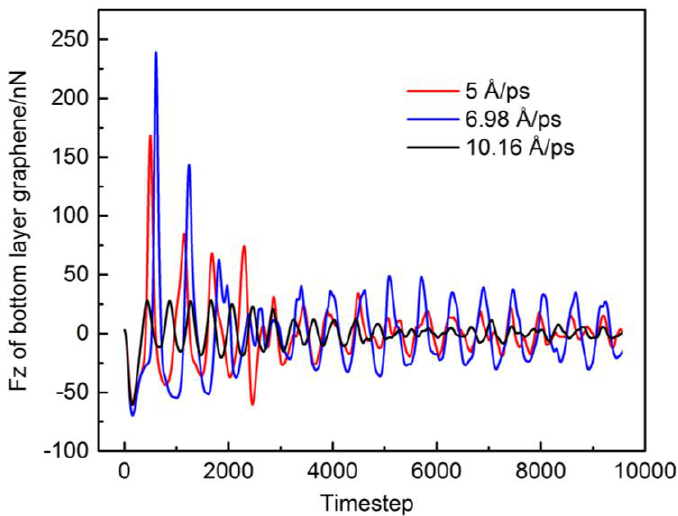
Figure 12. Fz of the bottom layer of graphene varying with timestep.